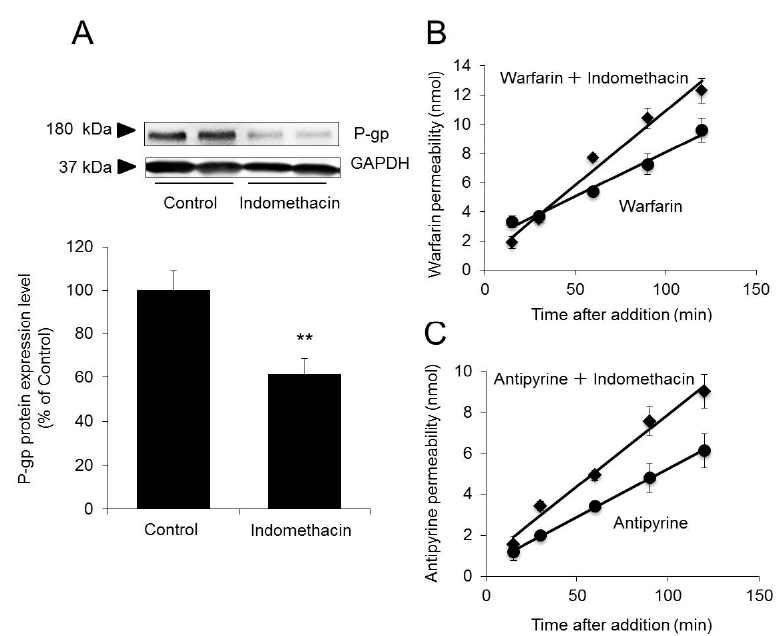
Figure 5. Effect of decreased P-glycoprotein (P-gp) expression on permeability to warfarin/antipyrine. Caco-2 cells were plated in Transwell plates and incubated for 21 days. ( A ) Indomethacin was added to the apical side of the Transwell plate. After 2 days, the protein expression of P-gp was analyzed by western blotting and normalized to GAPDH expression. The mean levels of P-gp protein expression in the control group were set as 100%. ( B ) Warfarin alone or a combination of warfarin and indomethacin was added to the apical side of the Transwell plate. The concentration of warfarin on the basal side was measured. ( C ) Antipyrine alone or a combination of antipyrine and indomethacin was added to the apical side of the Transwell plate. The concentration of antipyrine on the basal side was measured. The data are presented as the mean ± SD for six experiments. Student’s t -test: ** p < 0.01 vs. the control value.